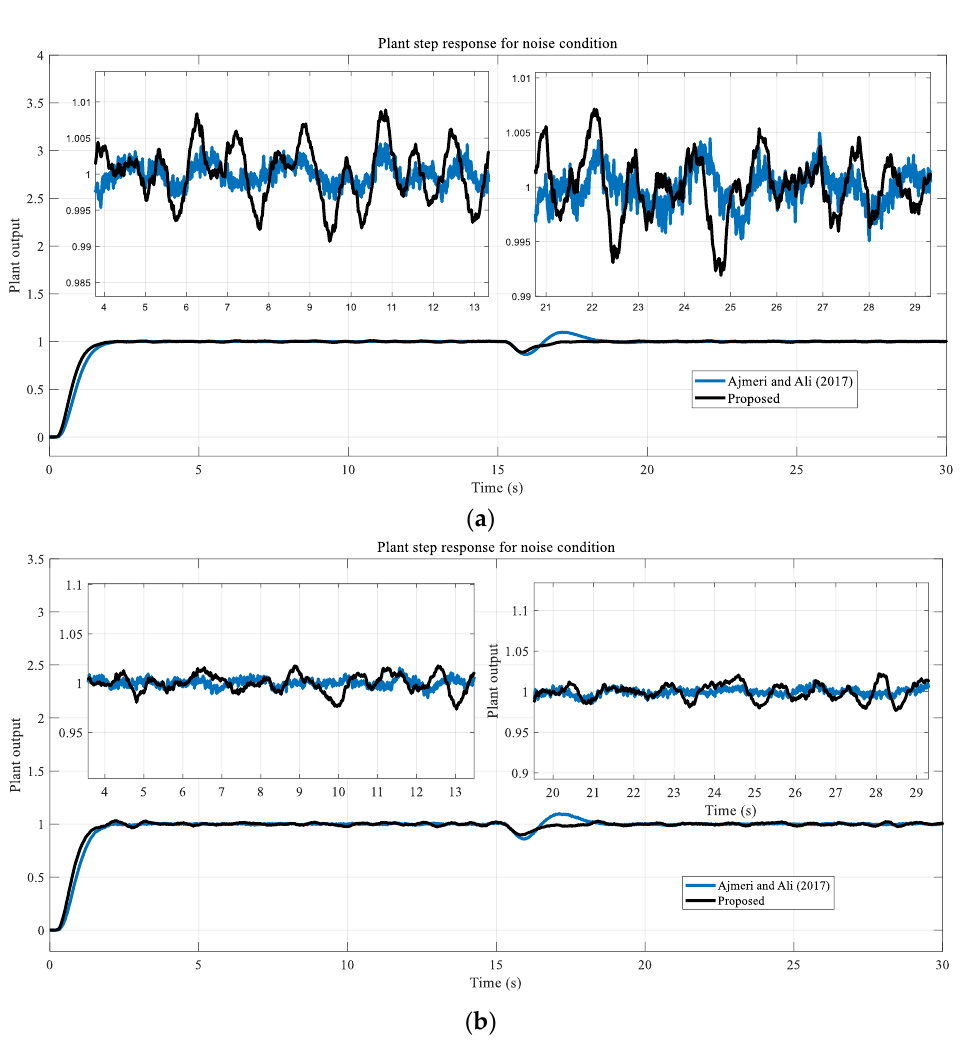
Figure 15. Performance comparison of the proposed method and the other methods, in terms of parameter changes, for Example 3 [15,16,18].